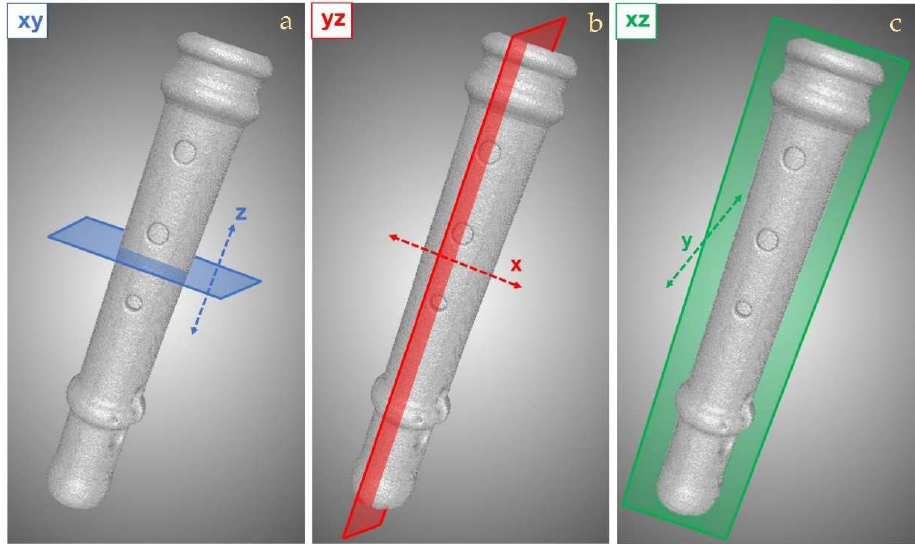
Figure 5. Schematic representation of the three CT reconstructed slices direction: ( a ) transversal or horizontal sections correspond to the xy plane along the z axis; ( b ) sagittal or lateral sections correspond to the xz plane along the y direction; ( c ) longitudinal or vertical sections correspond to the yz plane along the x direction .